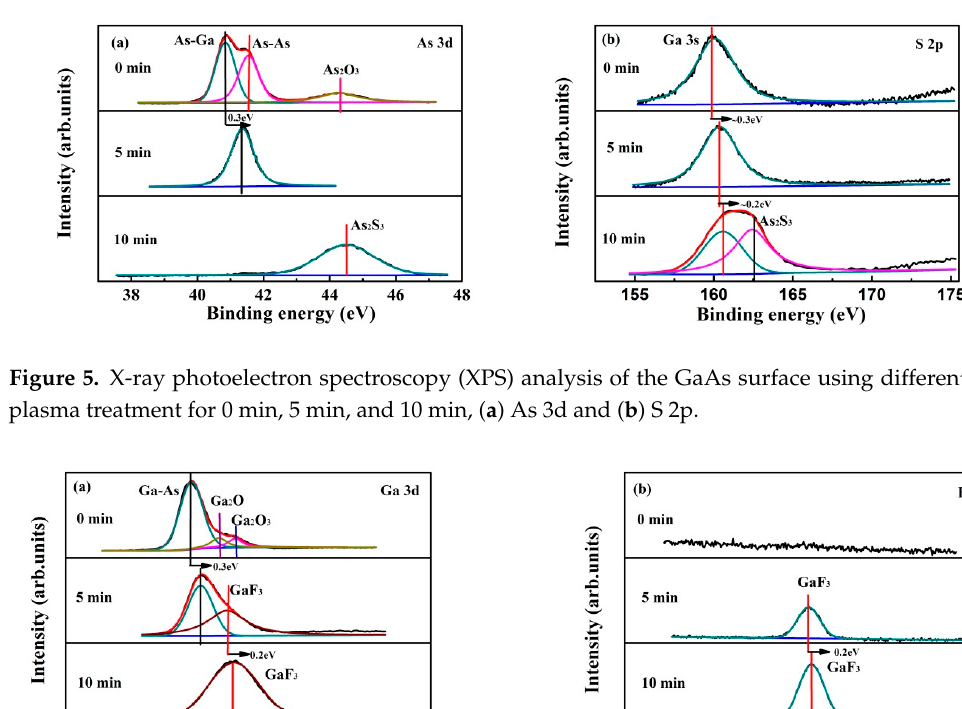
Figure 7. The PL intensity of GaAs samples prepared by an optimized passivation process. A SiO 2 coating on a passivated GaAs surface was done to improve the stability of the passivation layer by RF sputtering. Samples with different thicknesses of SiO 2 were prepared to test the anti- reflection effect, as shown in Figure 8. The PL intensity is only about 1.05 times higher than untreated when the SiO 2 film is about 60 nm thick, which implies that a thin SiO 2 coating below 60 nm has little influence on the PL intensity measurement.